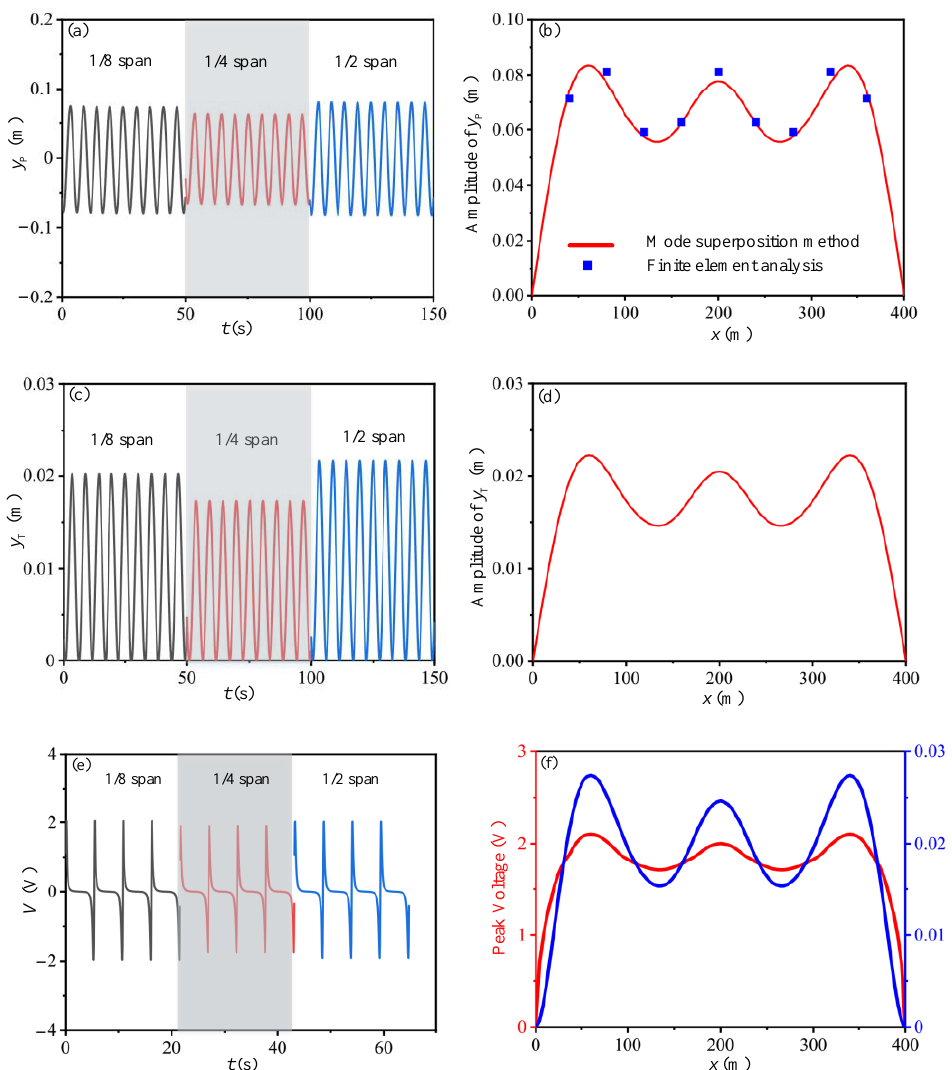
Figure 9. Influence of the installation position of the TENG device at pipeline on its output performance. ( a , b ) is the influence of the position at pipeline on the dynamic response of pipeline; ( c , d ) is the influence of the installation position of TENG at pipeline on the dynamic response of the mass-spring base; ( e , f ) is the influence of the installation position of TENG at pipeline on its electric output.